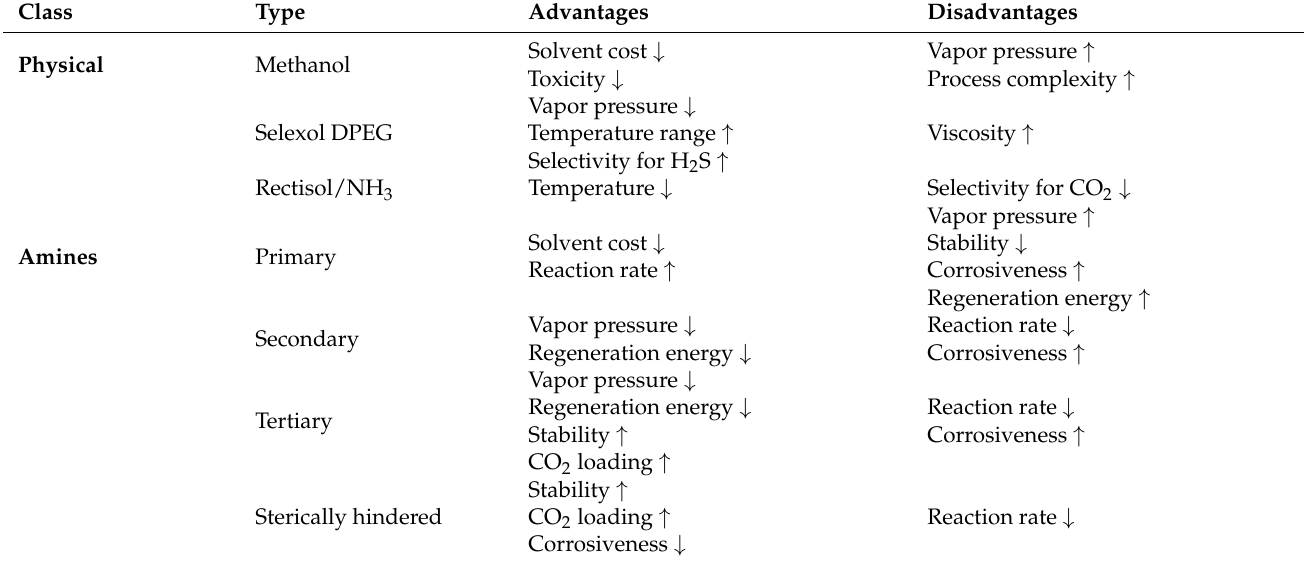
Table 2. Characteristics of different solvents for CO 2